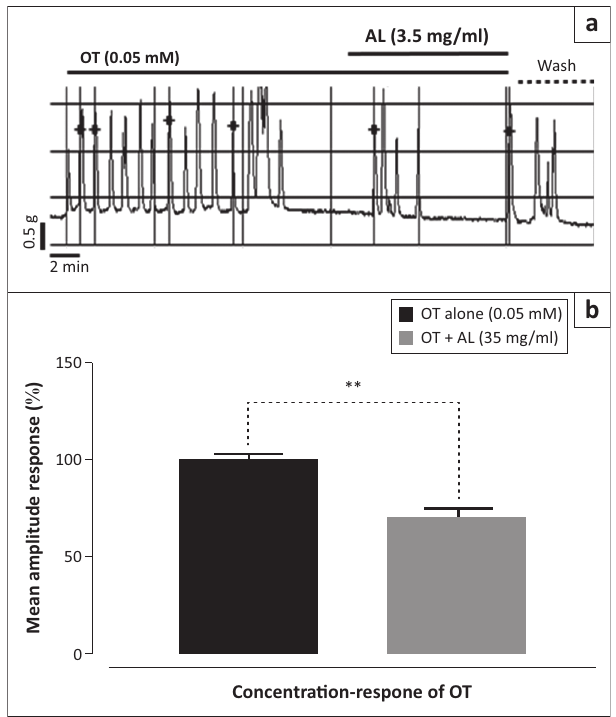
FIGURE 5: Effect of Alchornea laxiflora (AL) on oxytocin (OT)-induced uterine contraction in Ca 2+ -free medium. Figure a shows representative recordings of the effect of AL on OT-induced uterine contraction in media containing zero calcium. Figure b shows bar plots analysing the effect of AL on OT-induced uterine contraction in Ca 2+ -free medium. A significant inhibition of OT by AL was observed under these conditions. n = 4 animals; ** p < 0.01.